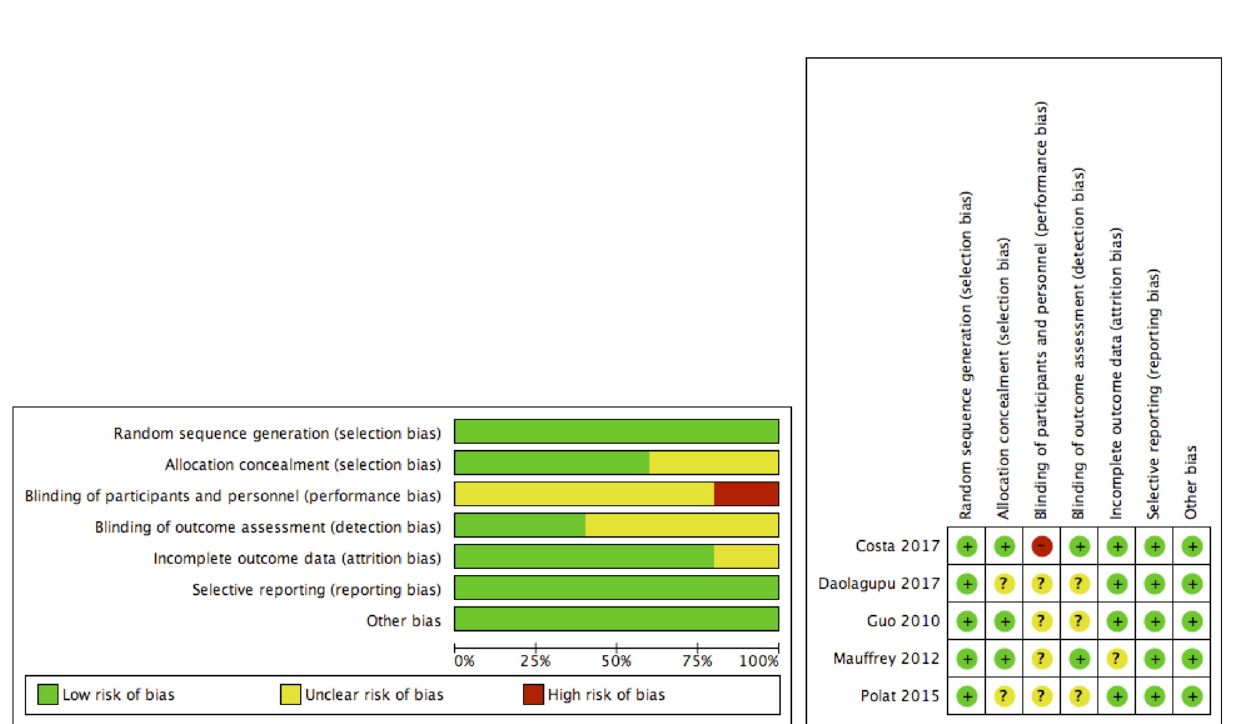
Fig. 2. Risk of bias